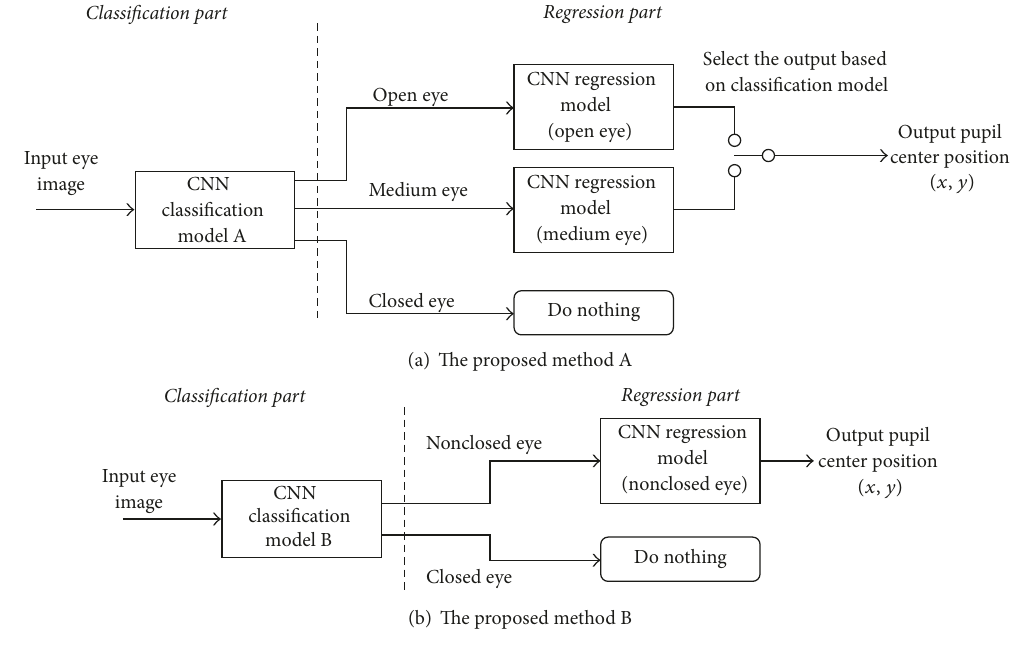
Figure 1: Proposed two-part CNN model. Table 1: Proposed CNN